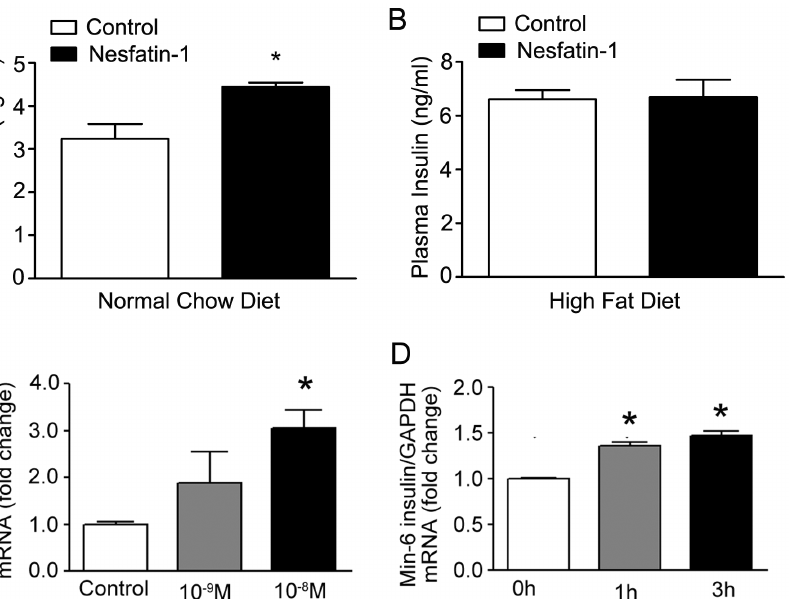
Figure 2. Effects of peripheral nesfatin-1 on insulin secretion. (A, B) Effects on mice. Mice were fed normal chow diets (NCD) (A) and high fat diets (HFD) (B) for 8 weeks, then received peripheral infusion of nesfatin-1 for 2 weeks. Eleven mice were examined for each condition. Data were expressed are mean 6 SEM; *P , 0.05 vs. control mice. (C, D) Effects on min6 cells. Cultured min6 islet cells were treated with nesfatin-1 or vehicle. Insulin mRNA expression was determined by real-time RT-PCR. Data were expressed are mean 6 SEM; Dose-dependent (C) and time-dependent responses (D) were shown. *P , 0.05 vs. control treatment.